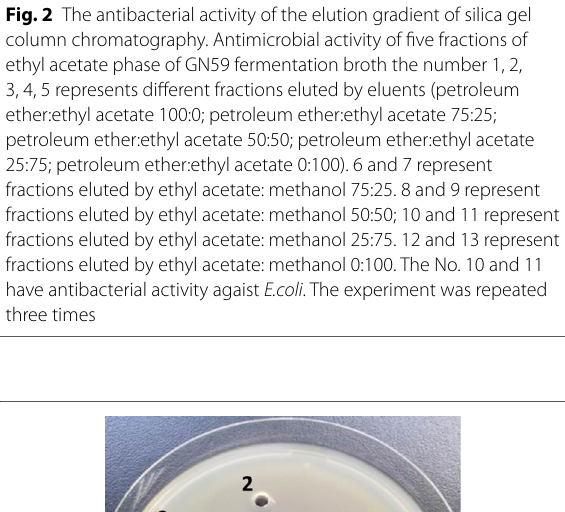
(Table 1). The minimum inhibitory concentration (MIC)